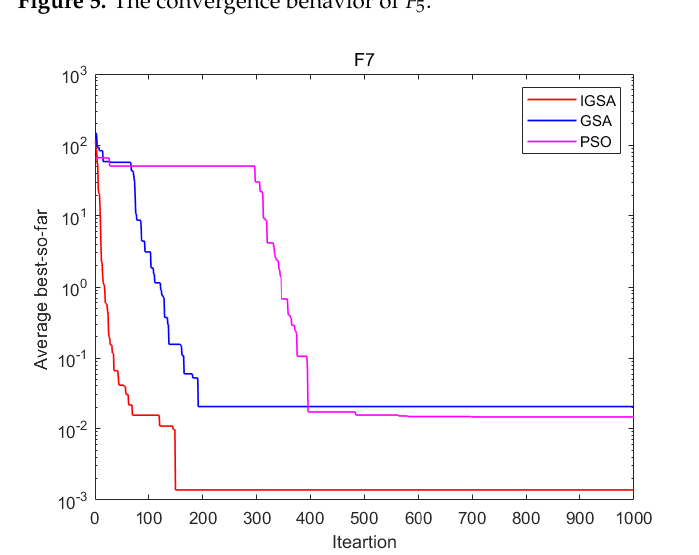
Figure 6. The convergence behavior of F 7